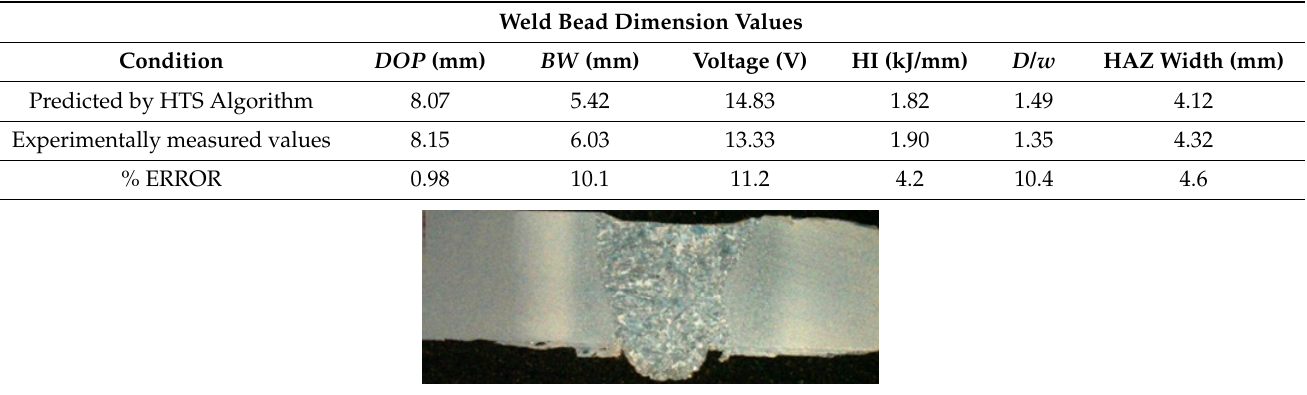
Table 10. Validation results for case study 4.